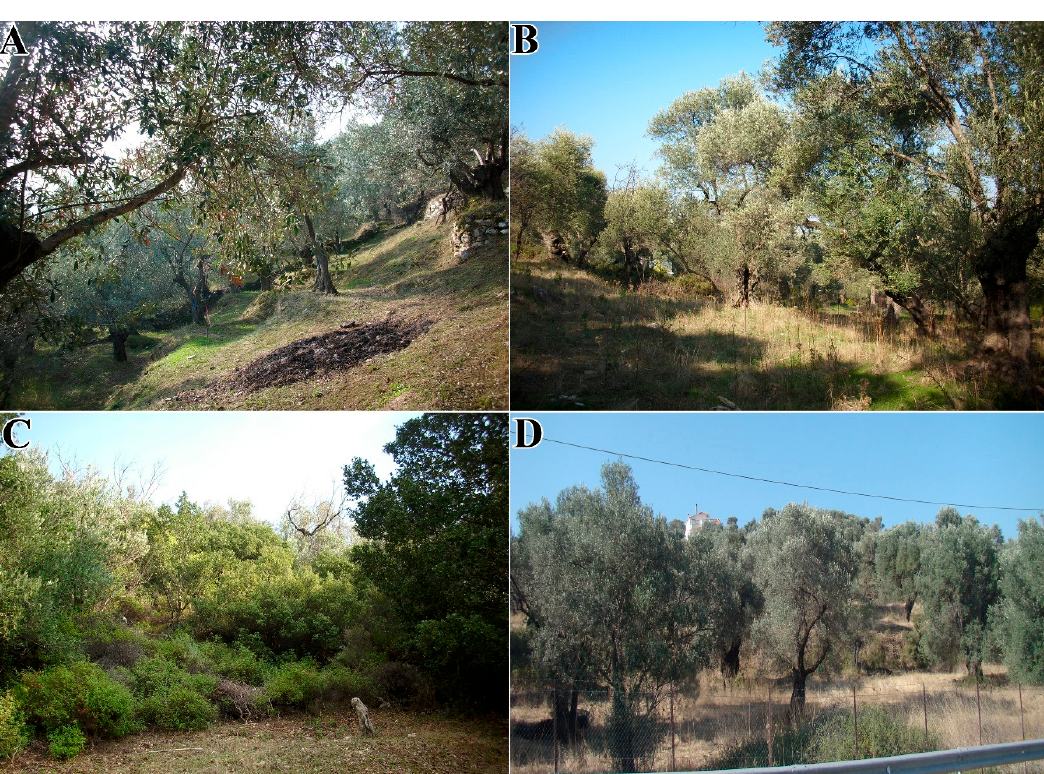
Figure 2. The typology of the four types of olive plantations [45]: ( A ) labor-intensive plantations; ( B ) neglected plantations; ( C ) abandoned plantations; ( D ) housing plantations (photos by the authors).